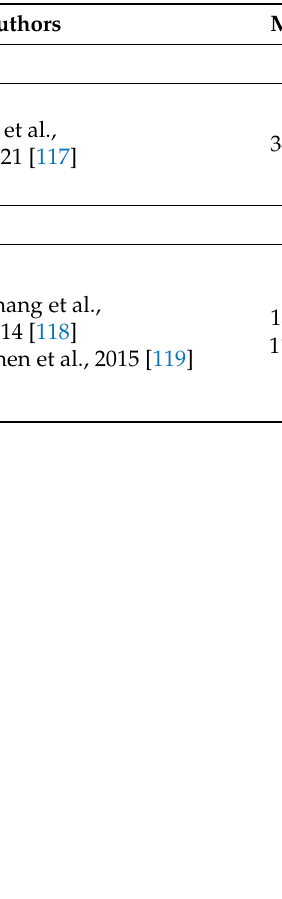
Table 11. Meta-analyses of leptin studies in OSA adults.